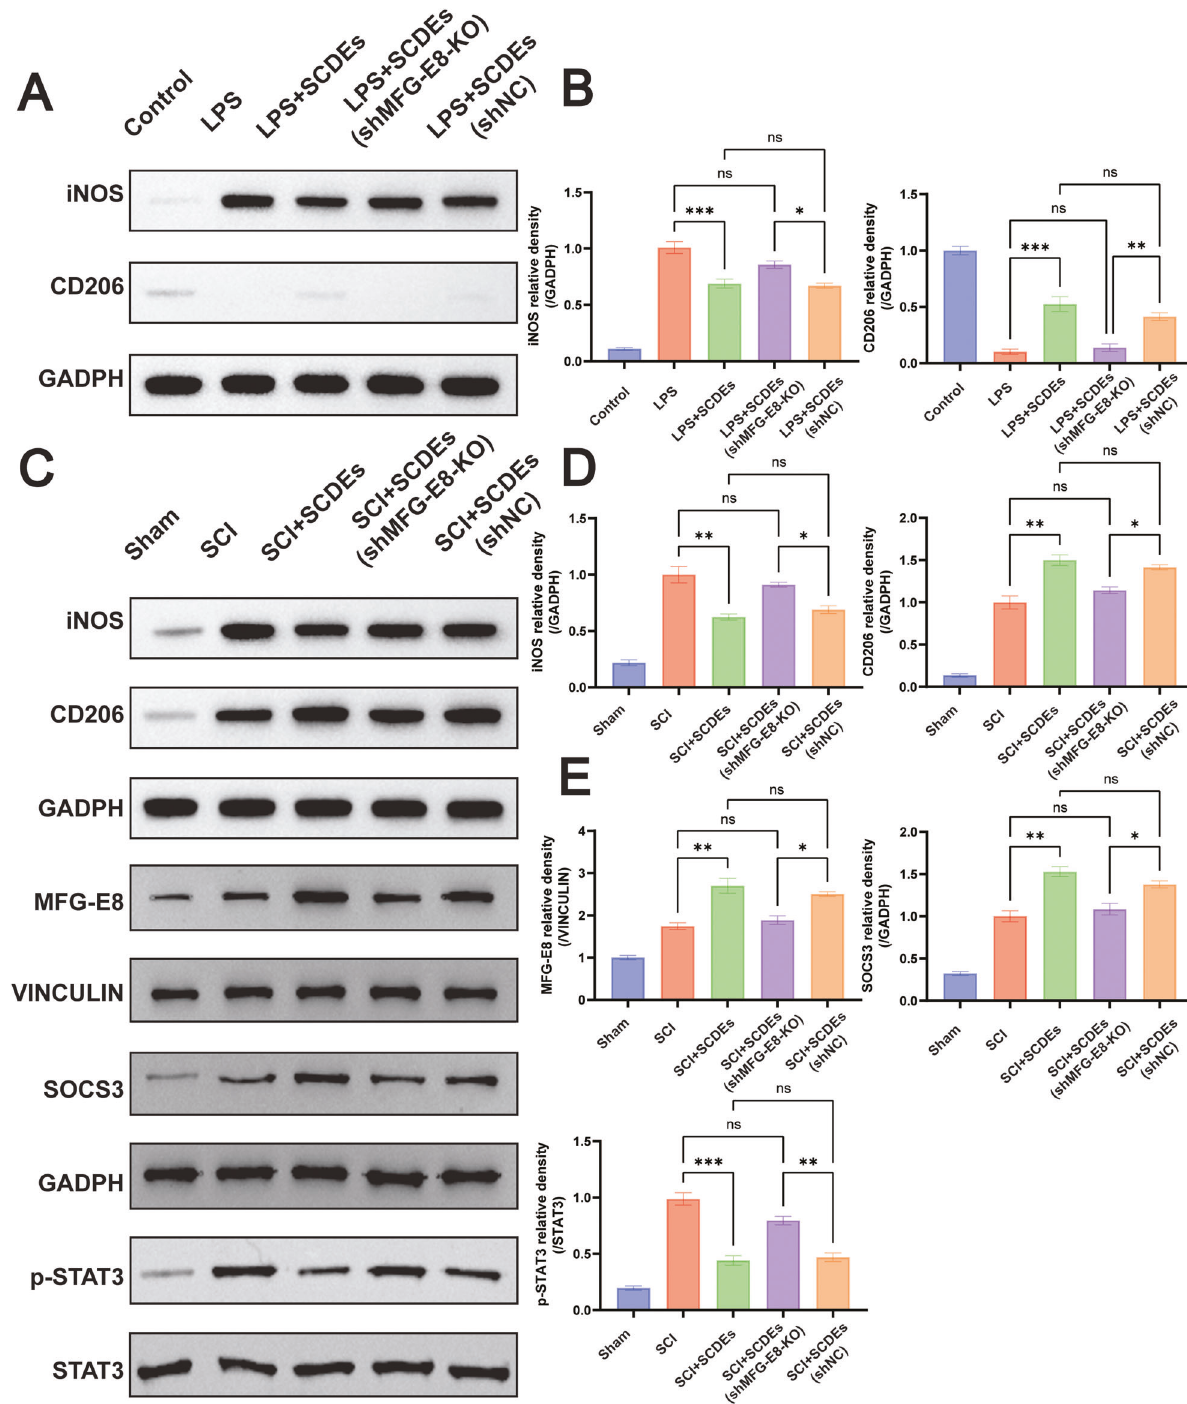
Fig. 9 M2 polarization induced by MFG-E8 in SCDEs was upregulated via SOCS3/STAT3 signaling pathway. A Representative western blots showed iNOS was reduced, and CD206 was increased, while MFG-E8 knockout reversed the effects of SCDEs in vitro. B Quantitative analysis of the iNOS/GAPDH and CD206/GAPDH ratio ( n = 3). C Representative western blots showing the reduction of iNOS and the increase of CD206, while MFG-E8 knockout reversed the effects of SCDEs in vivo. Representative western blots showed that SOCS3/STAT3 signaling was activated via MFG-E8 in SCDEs, while MFG-E8 knockout reduced the SOCS3 and increased the STAT3 in vivo. D Quantitative analysis of the iNOS/GAPDH and CD206/GAPDH ratio in vivo ( n = 3). E Quantitative analysis of the MFG-E8/GAPDH, SOCS3/GAPDH, and STAT3/GAPDH ratio and CD206/ GAPDH ratio in vivo ( n = 3). Data were presented as mean ± SEM. Results were analyzed by One-way ANOVA. Signi fi cance: ns-not signi fi cant, * P < 0.05, ** P < 0.01, *** P < 0.001. Western blot 12% SDS-PAGE and then transferred to a PVDF membrane. After being The protein concentration was measured by using the BCA assay blocked with 5% nonfat milk in TBST, the PVDF membrane was (Thermo Scienti fi c, #23225, MA, USA). Target proteins were separated by incubated with the primary antibody overnight and then incubated Cell Death and Disease (2023)